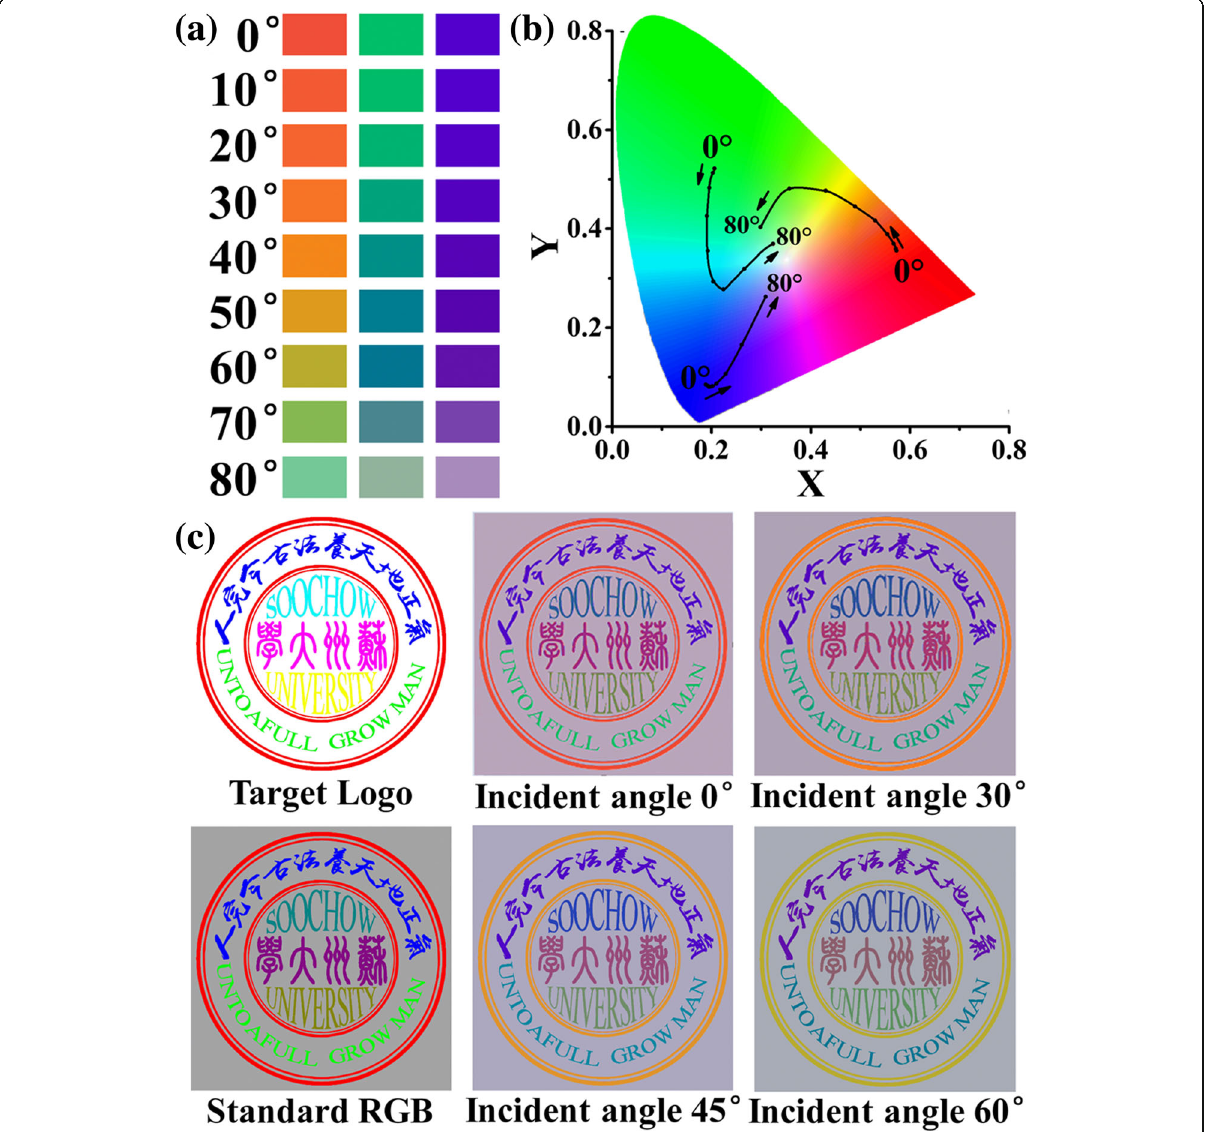
Fig. 5 a The evolutions of the RGB colors shown by the designed a-Si:H SCs with the incident angle. b The variations of the RGB positons in CIE 1931 coordinate with increasing the incident angle. c The logo patterns displayed by the a-Si:H SC under various incident angles (0°, 30°, 45°, and 60°). In c , the target logo and the logo by standard RGB are included for